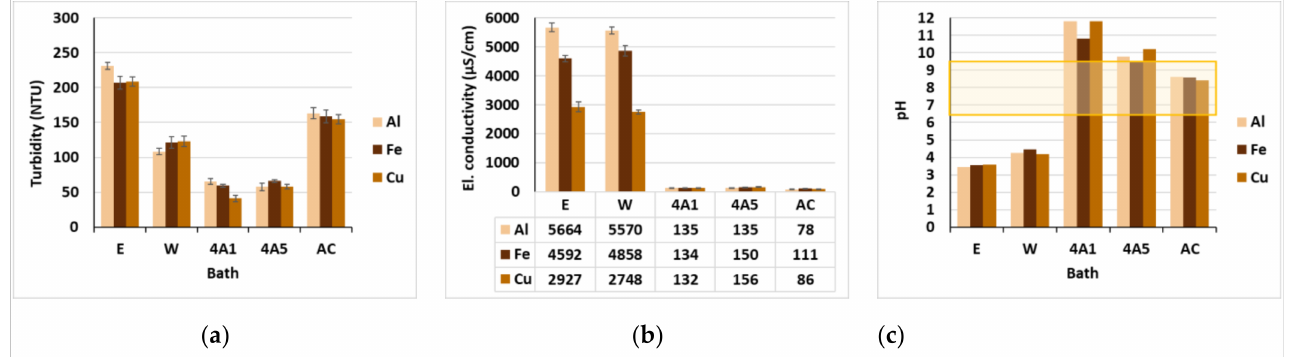
Figure 8. ( a ) Turbidity; ( b ) electrical conductivity; and ( c ) pH in